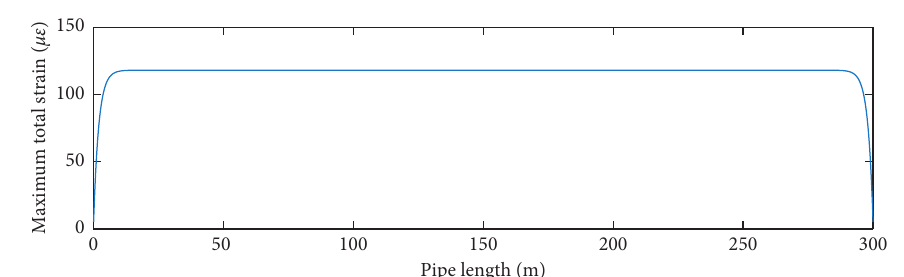
Figure 10: Maximum total strain of straight